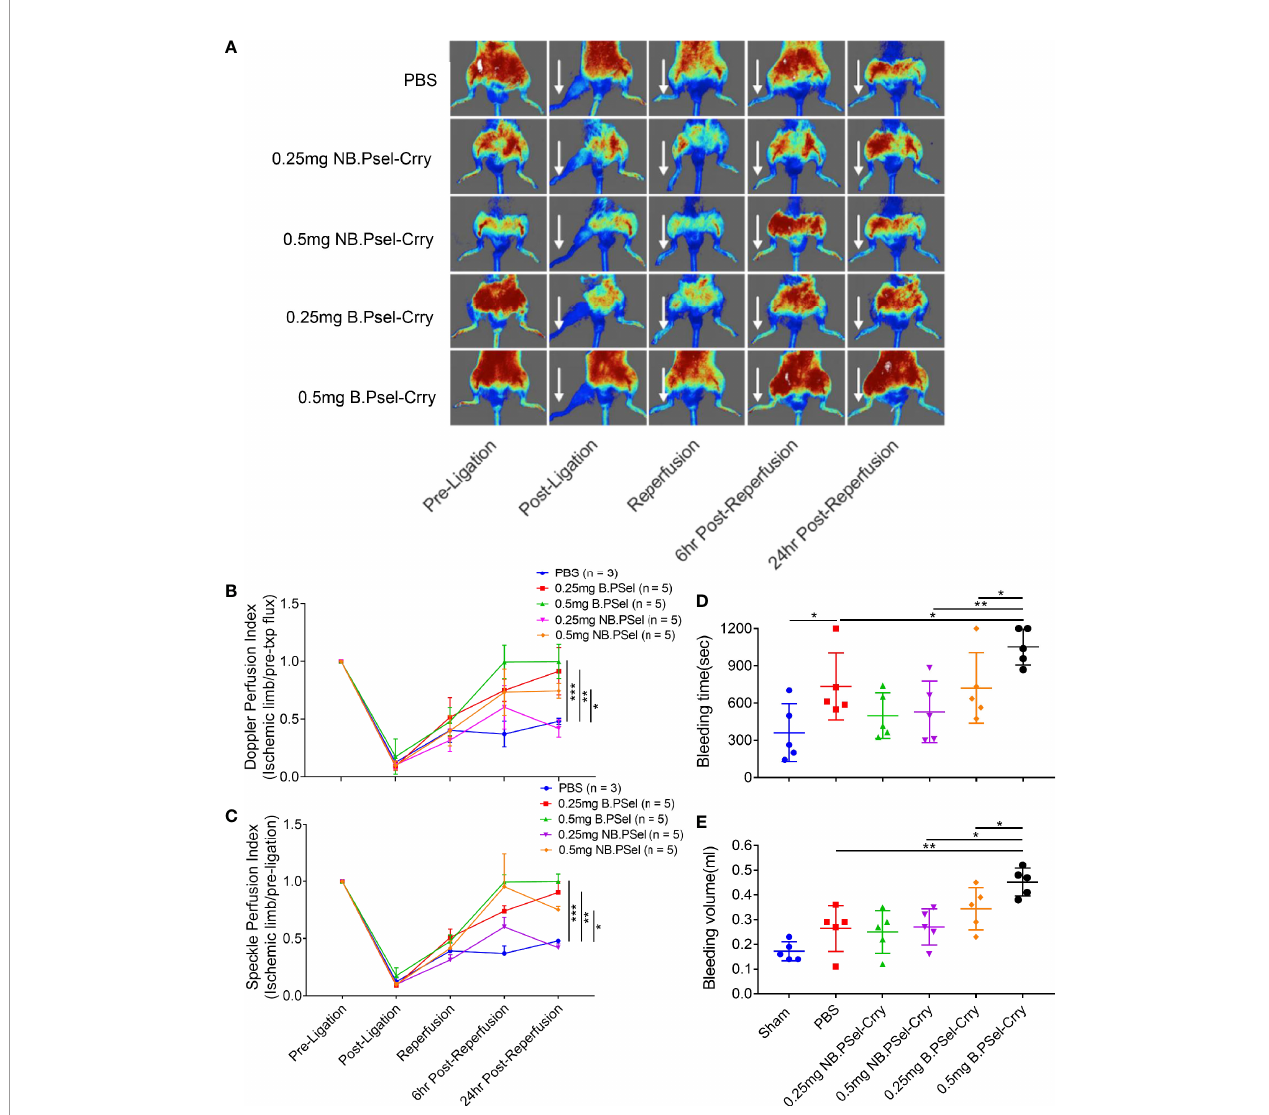
FIGURE 4 | Effect of B.PSel-Crry and NB.PSel-Crry on hindlimb perfusion following ischemia/reperfusion and on bleeding time and volume. Mice were injected with construct or PBS upon reperfusion after 2 h ischemia and hindlimb perfusion measured by laser Doppler fl ow of laser speckle imaging at indicated times. (A) Representative laser speckle doppler images from each treatment group, with arrows indicating ligated hindlimb. (B) Quanti fi cation of perfusion by laser Doppler fl ow using a single point on each paw and normalizing to pre-ligation value. Parametric One-Way ANOVA with Tukey ’ s correction. (C) Quanti fi cation of perfusion by laser speckle doppler using a point on each paw and normalizing to pre-ligation value. Parametric One-Way ANOVA with Tukey ’ s correction. Quanti fi cation data expressed as Mean ± SD; *p ≤ 0.05, **p ≤ 0.01, ***p ≤ 0.001. n = 5 for all groups. For bleeding determinations, indicated dose of construct or PBS administered via i.v. injection, and mice monitored over a 20 min. period after tail clip. (D) Tail bleed time. Bleeding time was signi fi cantly longer in mice treated with 0.5 mg dose of B.PSel-Crry. Parametric One-Way ANOVA with Tukey ’ s correction. (E) Tail bleed volume, which was signi fi cantly larger in mice treated with 0.5 mg dose of B.PSel- Crry. Parametric One-Way ANOVA with Tukey ’ s correction. Quanti fi cation data expressed as Mean ± SD; *p ≤ 0.05, **p ≤ 0.01. n =